Question: Sum up the contents of this chart in one sentence.
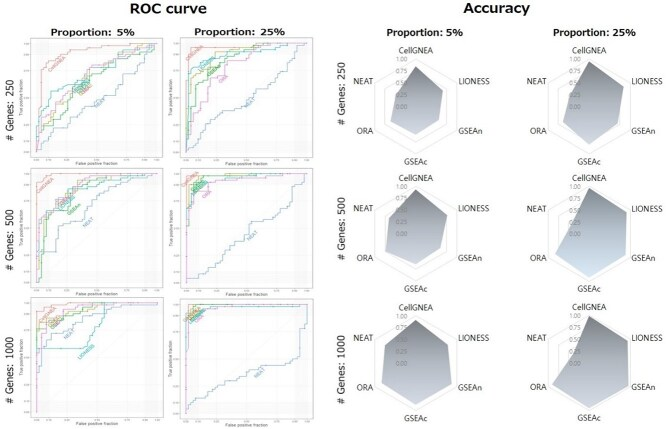
Answer: Accuracy (left) and ROC curve (right) of the gene network enrichment analysis evaluated using simulation studies. CellGNEA, Cell Line-Specific Gene Network Enrichment Analysis; LIONESS, Linear Interpolation to Obtain Network Estimates for Single Samples; GSEAn, Gene Set Enrichment Analysis with network structure; GSEAc, Gene Set Enrichment Analysis with centrality measure; ORA, Over-representation analysis; NEAT, network enrichment analysis test.